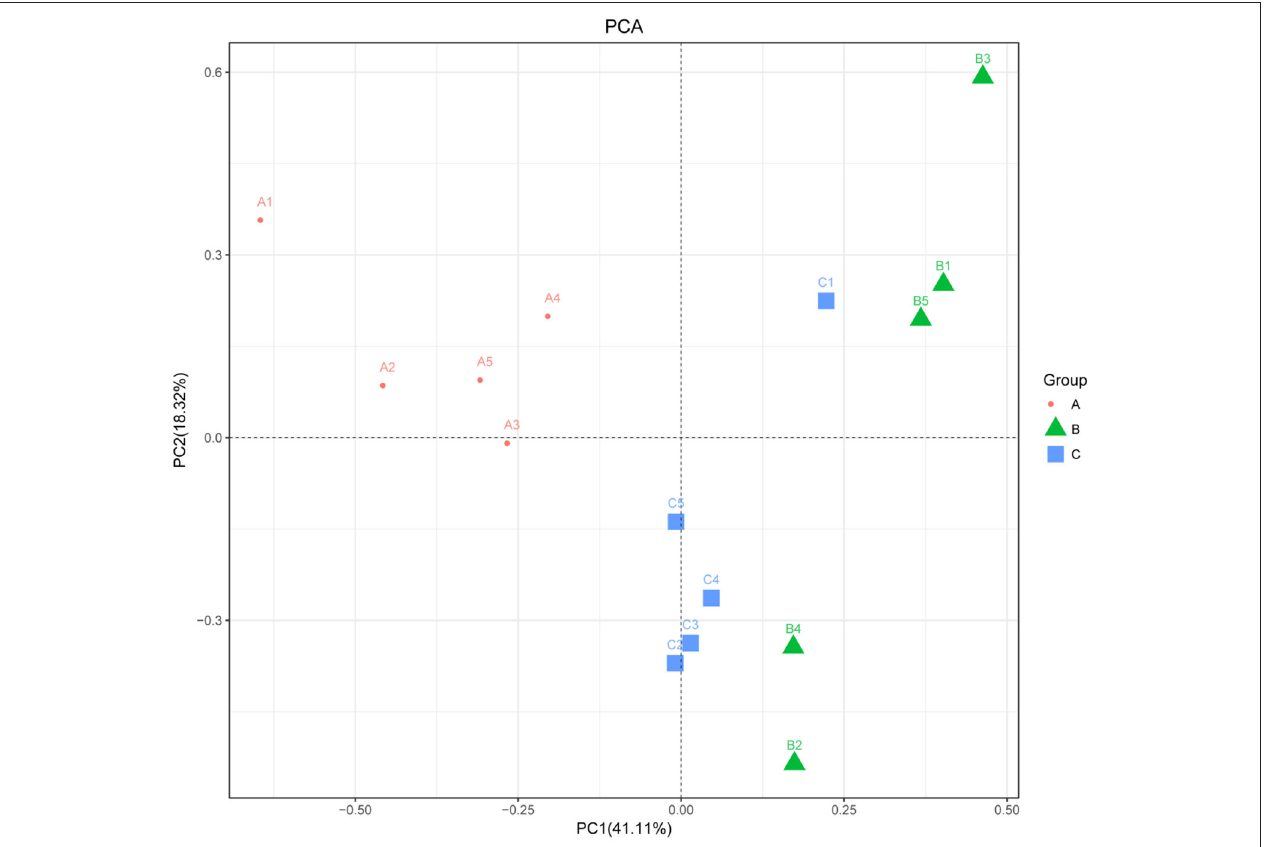
FIGURE 3 | Principal component analysis of the fecal microbiota. PCA map based on Euclidean distance. Each point indicates one sample. The distance of the two points indicates the difference in fecal microbiota. A: Healthy piglets; B: Diarrheal piglets; C: Treated